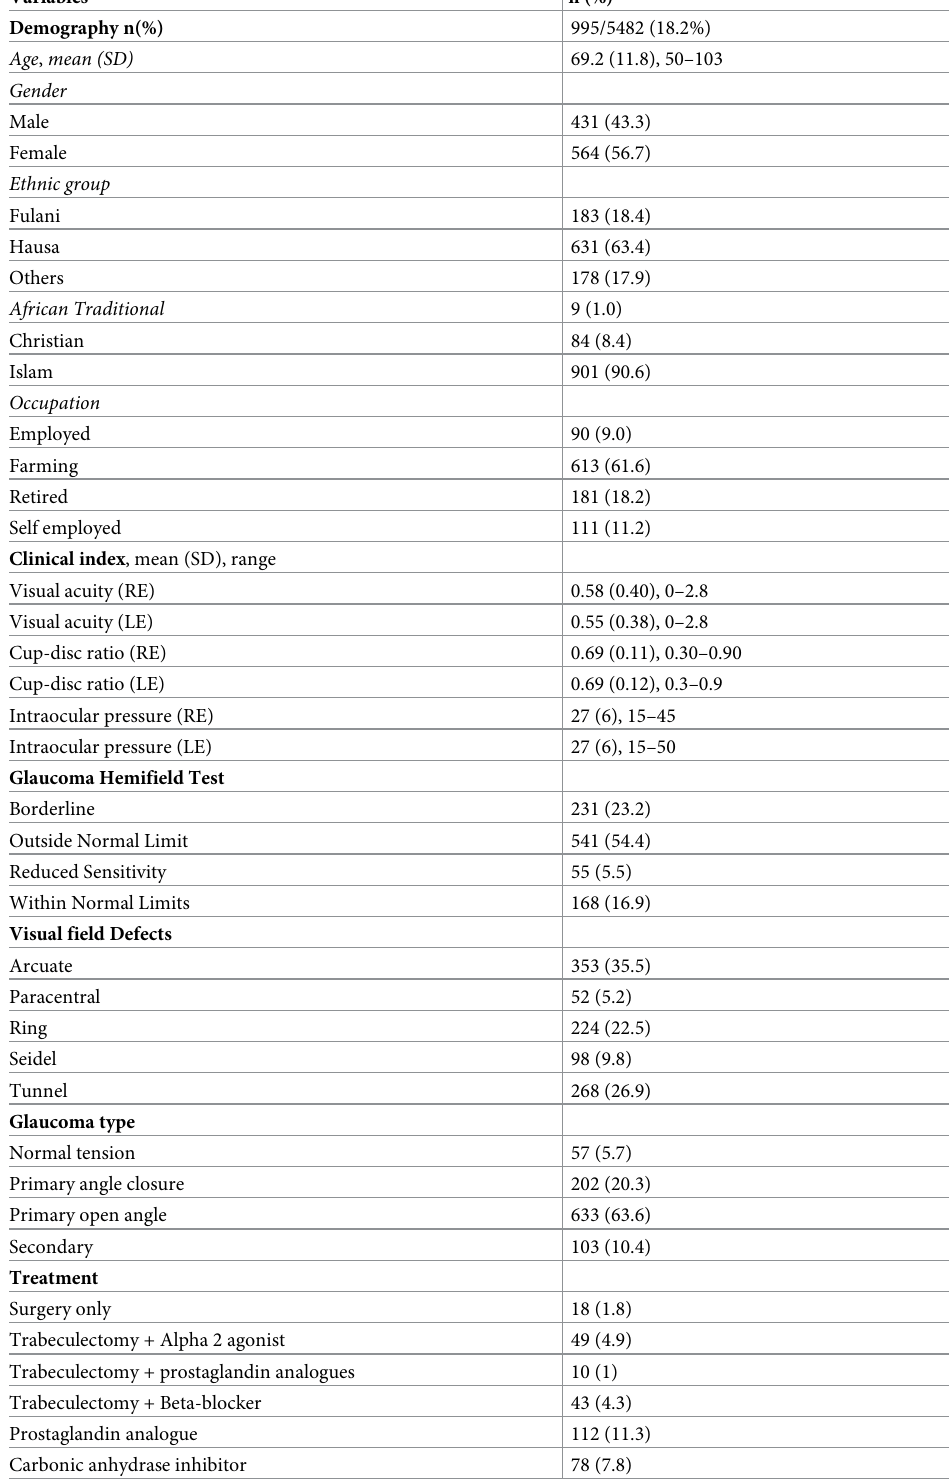
Table 1. Descriptive statistics of measured variables among glaucoma